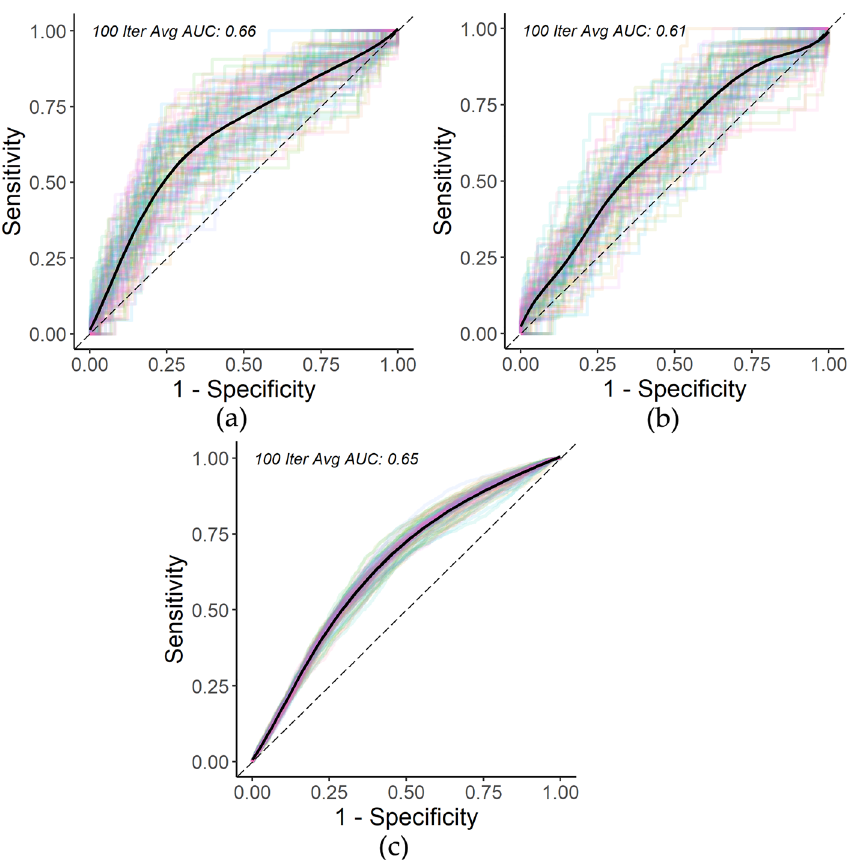
Figure 3. ( a ) Pediatric 30-year Cox second tumor time-dependent ROC curve over 100 iterations; ( b ) Adolescent 30-year Cox second tumor time-dependent ROC curve over 100 iterations; ( c ) Young adult 30-year Cox second tumor time-dependent ROC curve over 100